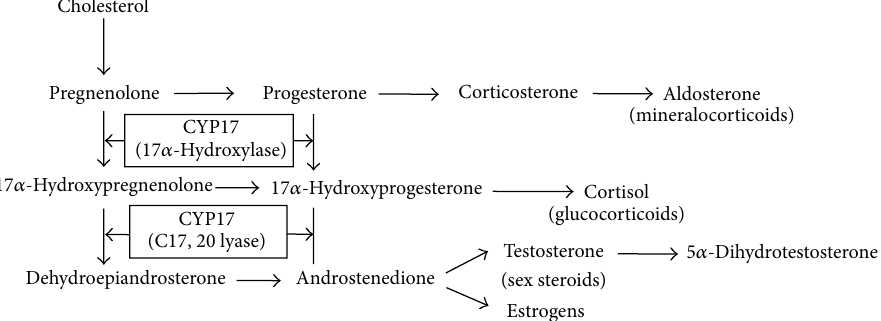
Figure 1: Simplified pathway of steroid hormone biosynthesis and the role of CYP17A1 . CYP17A1 encodes the enzyme cytochrome P-450c17 𝛼 (CYP17) that catalyzes steroid 17 𝛼 -hydroxylase and 17,20-lyase activities and is hence essential for the synthesis of glucocorticoids (17 𝛼 - hydroxylase activity) and sex steroids (17,20 lyase activity). Adapted from Molina and Belldegrun, 2011